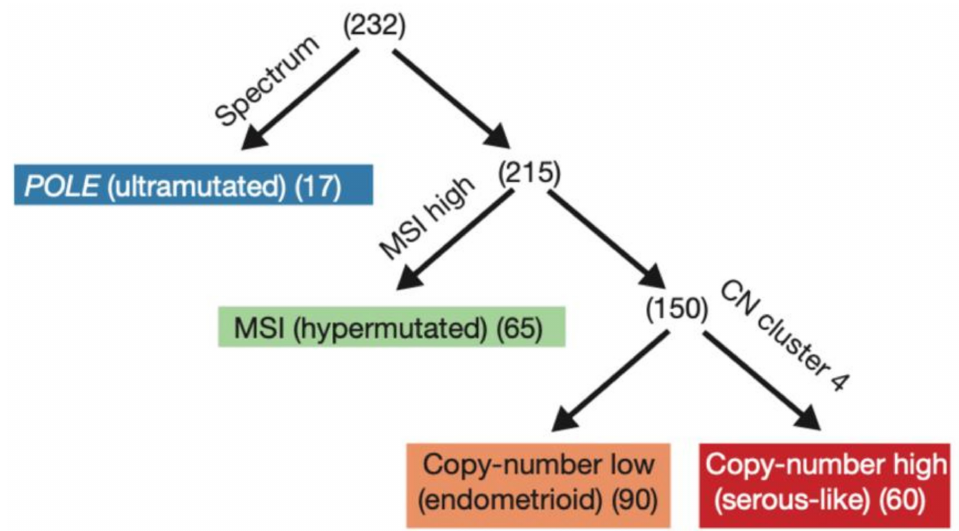
Figure 1. The TCGA (The Cancer Genome Atlas) 2013 original classification. Reprinted with per- mission from “Integrated genomic characterization of endometrial carcinoma” by Levine et al. [2]. Molecular classification into the four groups by (1) nucleotide substitution frequencies and patters, (2) MSI status, and (3) copy-number cluster; POLE polymerase epsilon, MSI microsatellite instability, CN copy